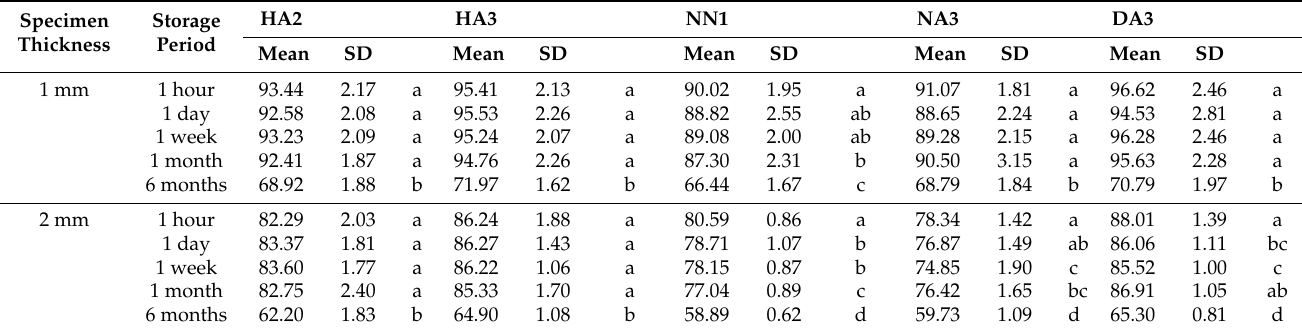
Table 2. Mean L* values of the 3D printable material specimens after different storage periods. Specimen Thickness